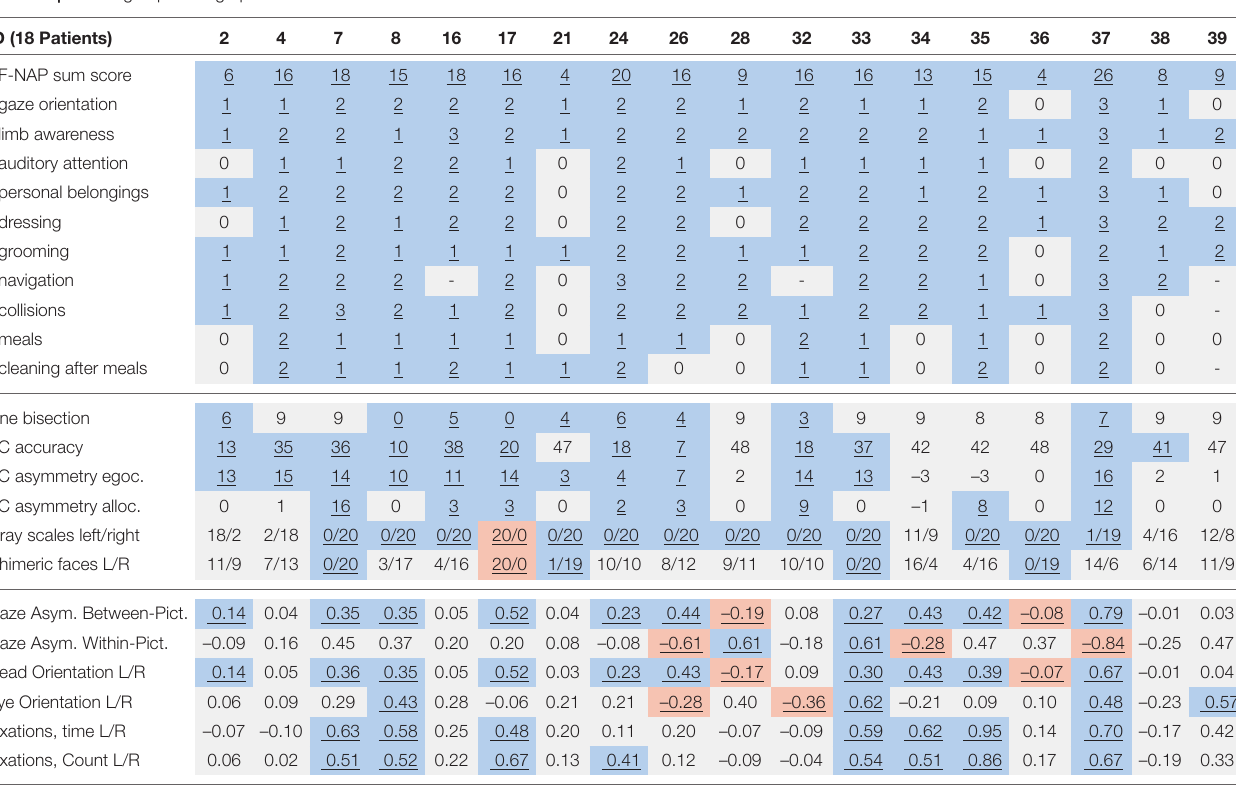
TABLE 5 | Patient group demographics and results from conventional and VR